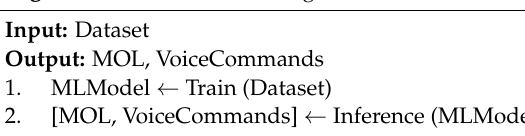
Algorithm 4: Machine learning Module